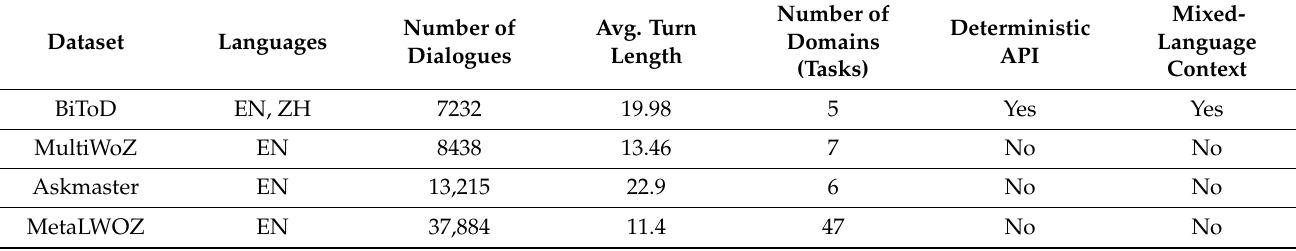
Table 3. Summary of the characteristics of different common task-oriented dialogue